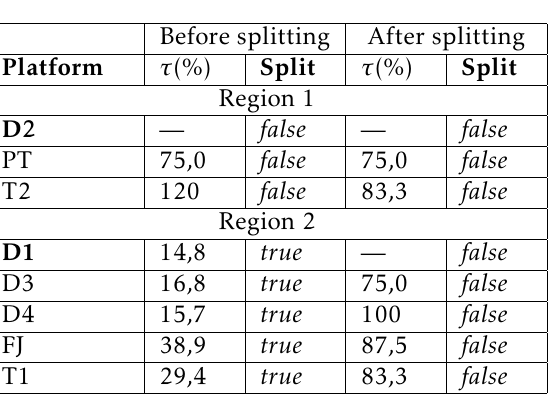
Table 4. Metrics measured for Region 1